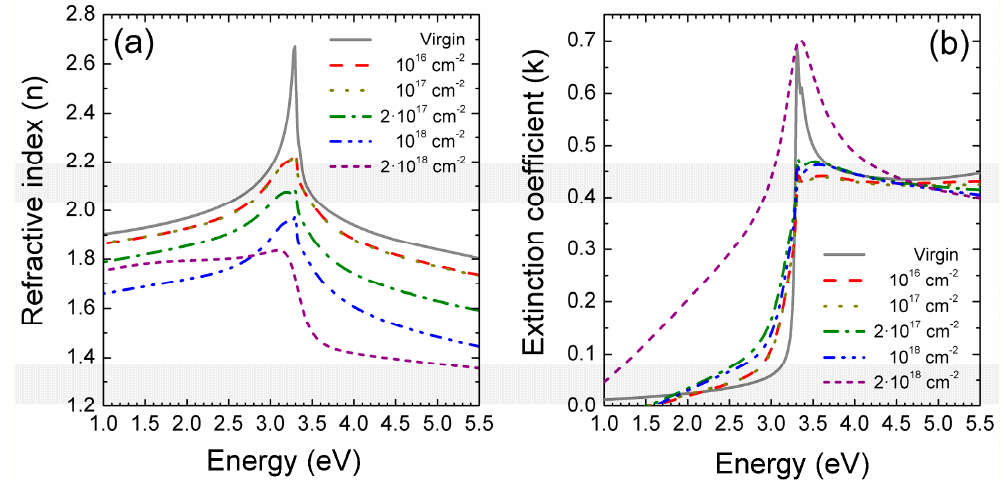
Figure 7. Refractive index ( a ) and extinction coefficient ( b ) extracted from the ellipsometric model for the ZnO damaged layer at the different fluences. Note the complete overlapping of the optical constants at low fluences (curves for 10 16 and 10 17 cm − 2 ).